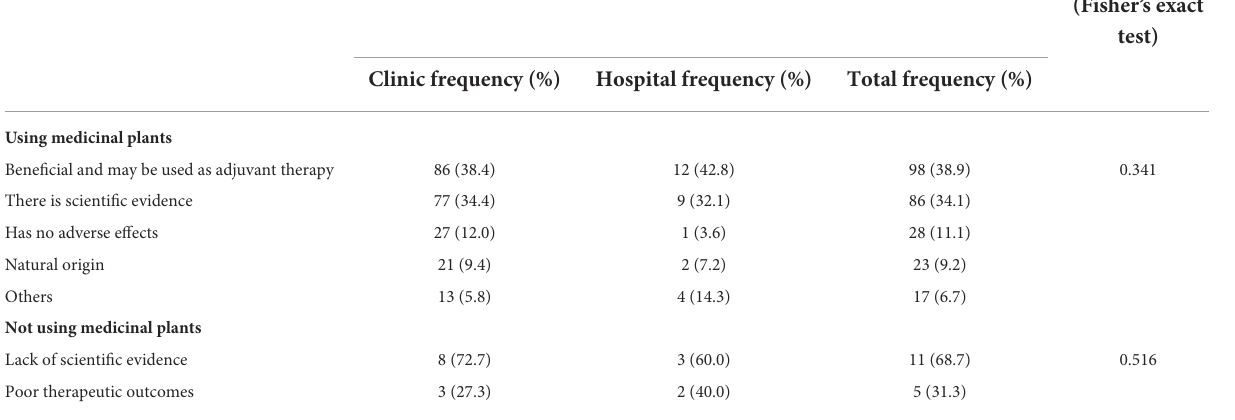
TABLE 1 Reasons for using or not medicinal plants among the Spanish small animal veterinarians ( n = 268).